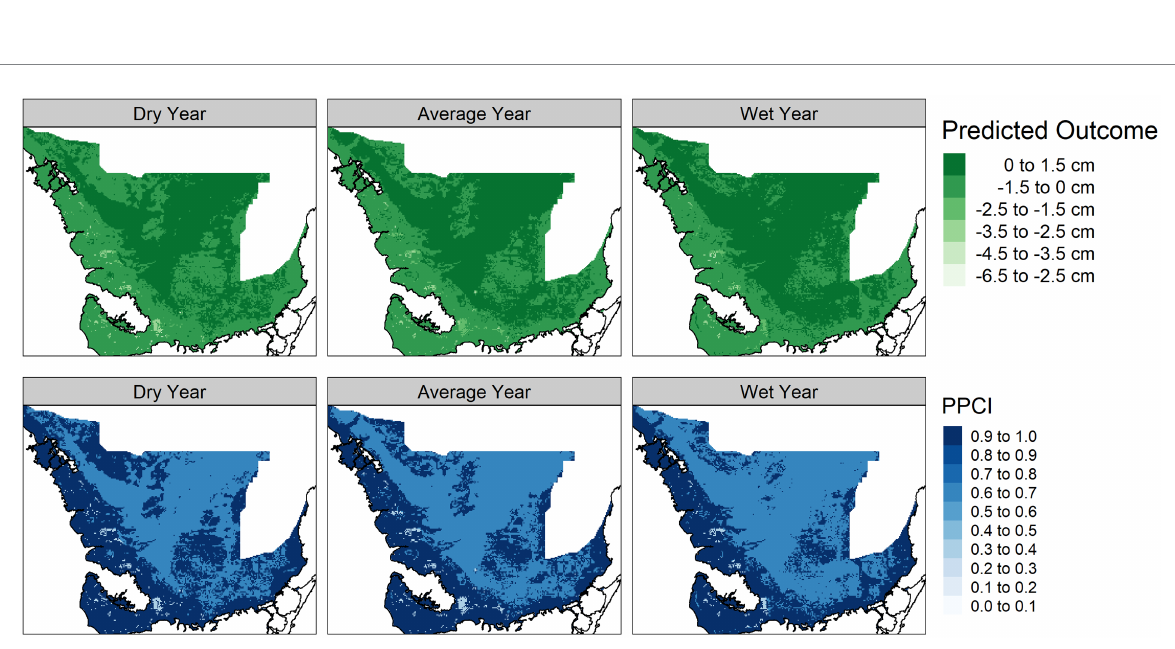
FIGURE 7 Predicted sawgrass peat accumulation module outcome (top panel) and posterior probability certainty index (PPCI, bottom panel) for a dry (2014), average (2007), and wet (2003) year chosen from